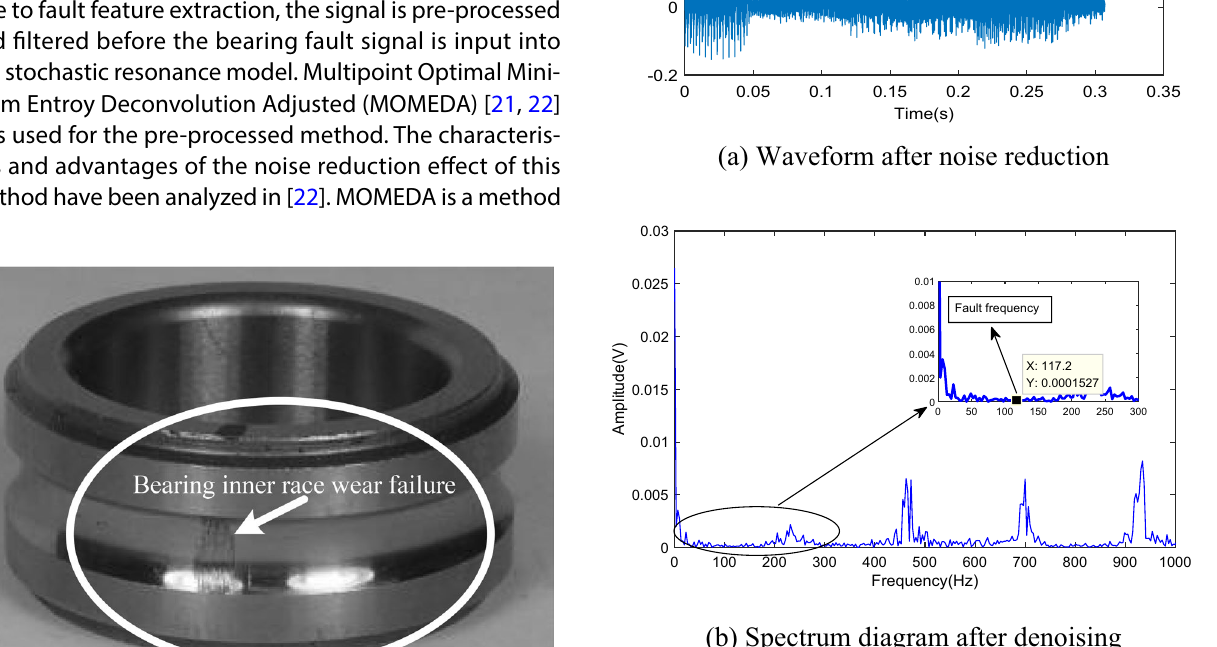
(b) Spectrum diagram after denoising Fig. 6 Vibration signal pre-processing calculation and analysis of noise reduction